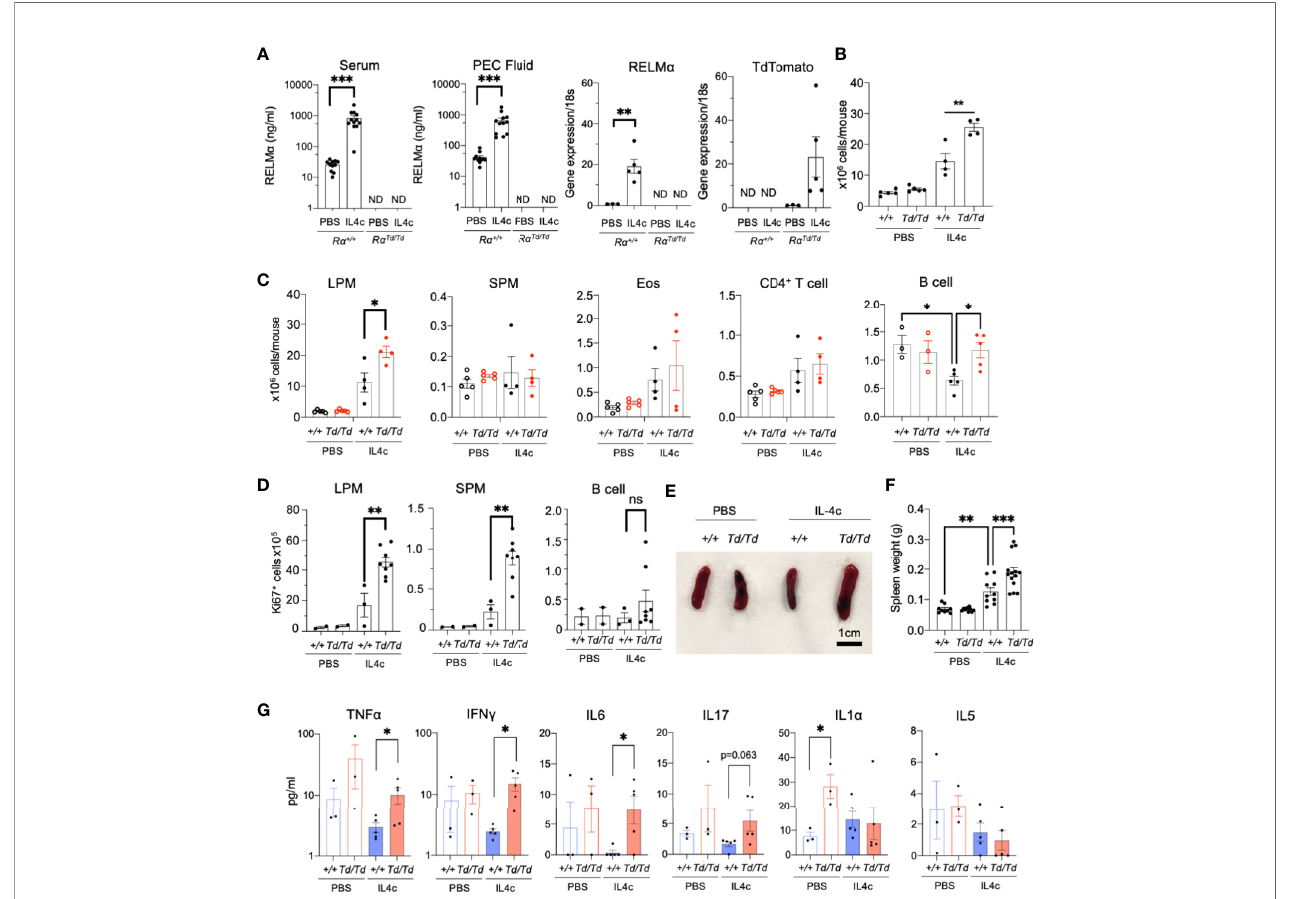
FIGURE 2 | Increased IL-4-induced pathology in RELM a Td/Td mice. PBS or IL4c-injected R a +/+ or R a Td/Td mice were sacri fi ced at day 4 followed by evaluation of spleen and peritoneal cavity responses. (A) Peritoneal fl uid and serum RELM a levels measured by ELISA, and RELM a and Td RNA was measured by peritoneal cell qRT-PCR as relative expression to PBS and normalized to 18s transcript. R a expression was normalized to the PBS R a +/+ group (set at “ 1 ” ) (B, C) Peritoneal in fl ammation and subset frequency evaluated by cell counts and fl ow cytometry analysis for small and large peritoneal macrophages (SPM and LPM), eosinophils, CD4 + T cells and B cells. (D) Peritoneal cell proliferation assessed by Ki67 staining. (E, F) Spleen size and weight were measured. (G) Serum cytokines were quanti fi ed. Results shown are representative of 3 independent experiments (n=4-8 per group). ND, not detected. *, p ≤ 0.05; **, p ≤ 0.01; ***, p ≤